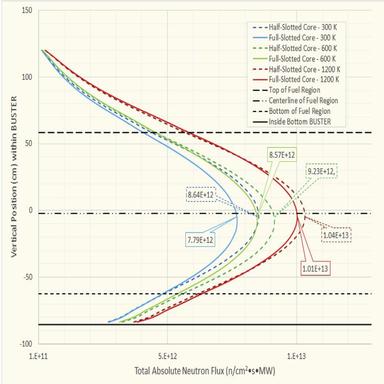
Comparison of Neutron Flux Axial Profile with Increasing Core Temperatures.